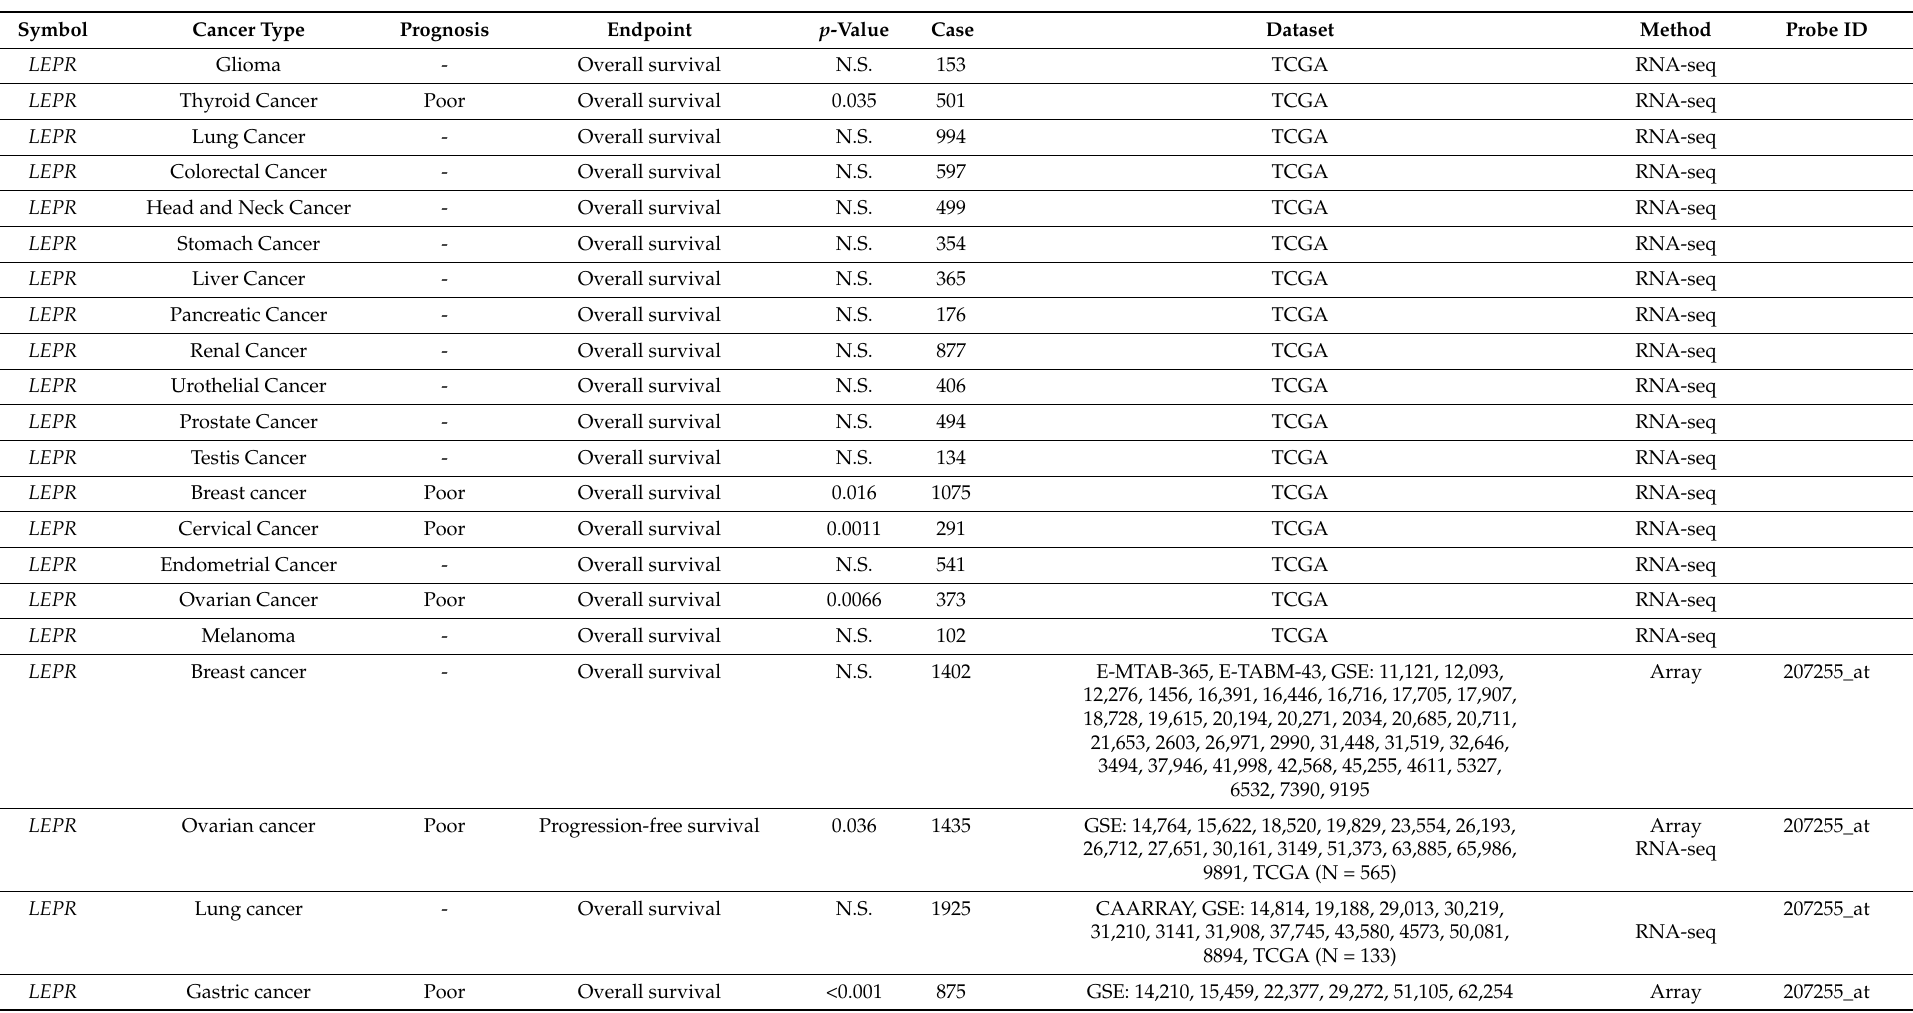
Table 4. Correlation of LEPR with cancer patient